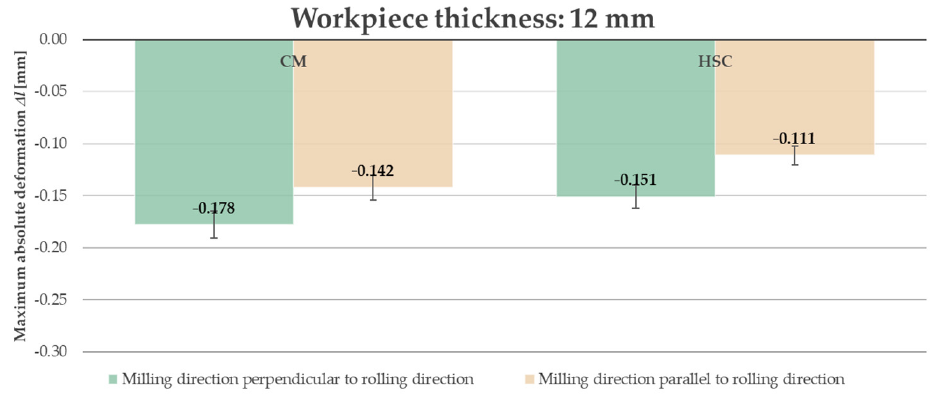
Figure 14. Comparison of the maximum absolute deformations ∆ l depending on the ratio of the milling direction to the rolling direction for the semi-finished product with a thickness of 12 mm.